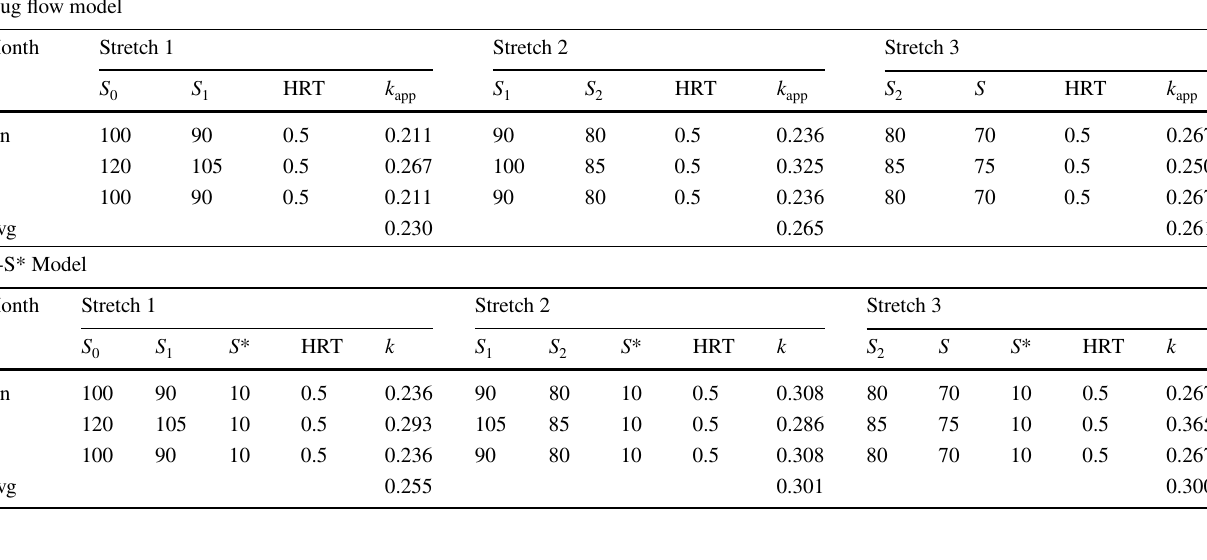
Table 5 Computed values of overall reaction rate parameter for all